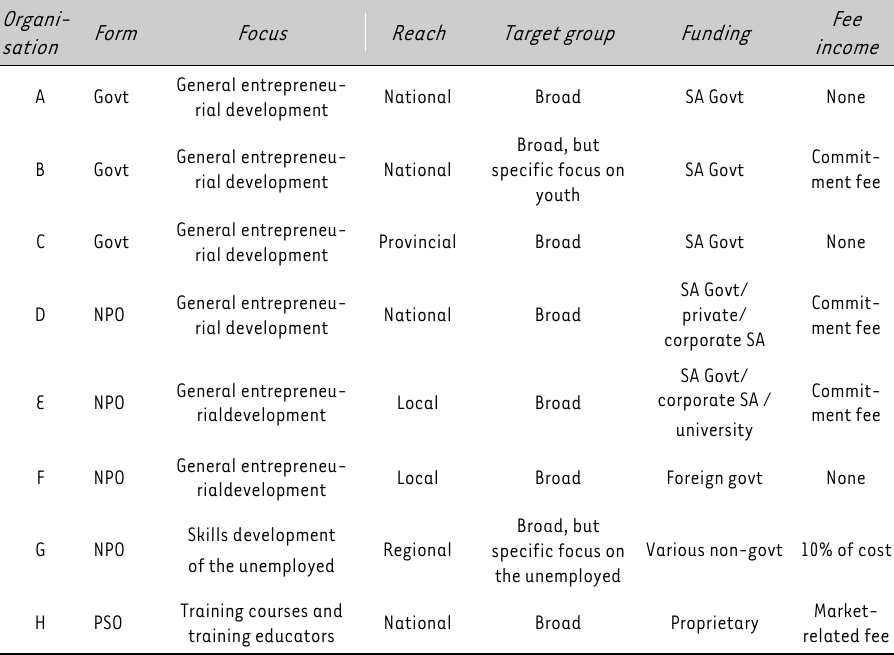
Profile of organisations in the